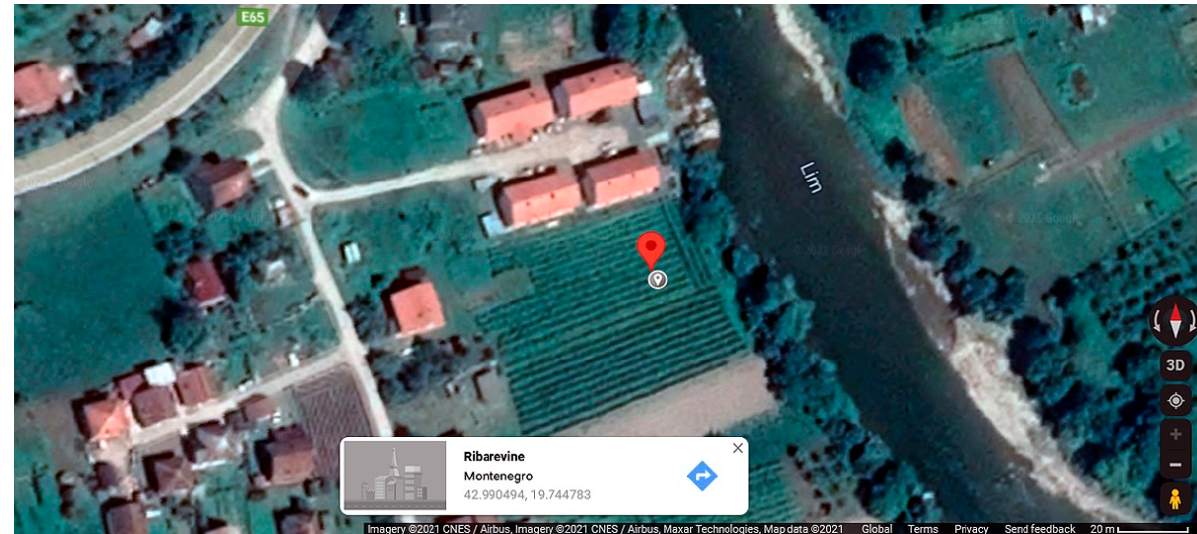
Figure 2. Position of the study area in Ribarevina, Bijelo Polje, Montenegro (42°59 ′ 25.8 ″ N 19°44 ′ 41.2 ″ E; 42.990494, 19.744783), source Google maps.